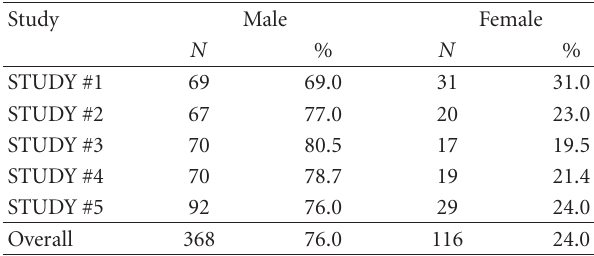
Table 3: Sex distribution by